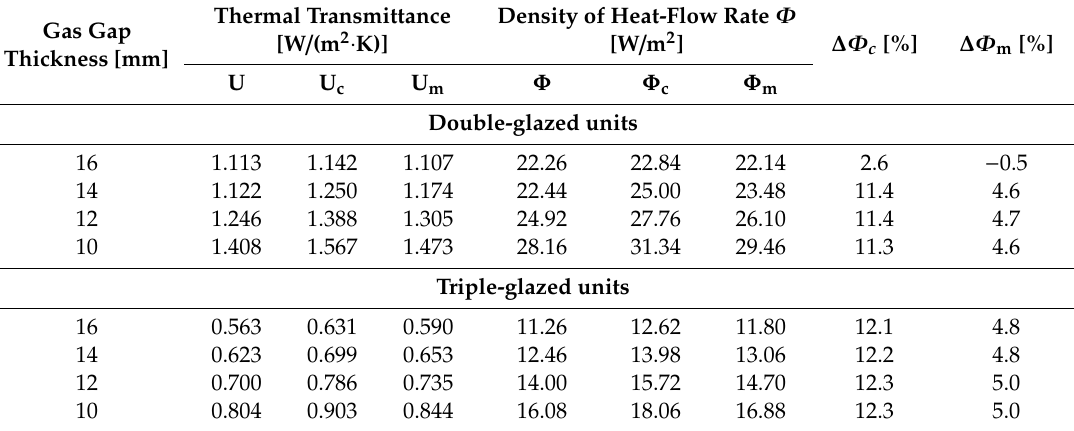
Table 6. Quantities describing heat losses by IGUs under conditions for a “mild winter” (Variant 2) and atmospheric pressure increase by ∆ p = 3